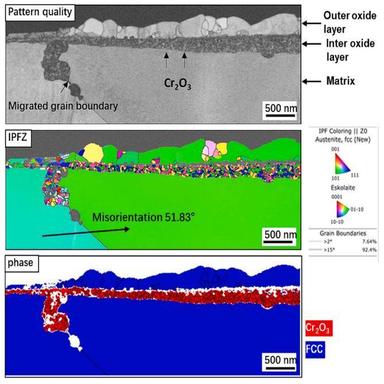
Pattern quality map, IPFZ map and phase map of the oxide scale after exposure in 600 ◦C/25 MPa SCW for 1000 h (chromite oxides, NiO, Fe3O4 and austenite matrix in blue, Cr2O3 in red, step size = 10 nm). (For interpretation of the references to colour in this figure legend, the reader is referred to the web version of this article.)